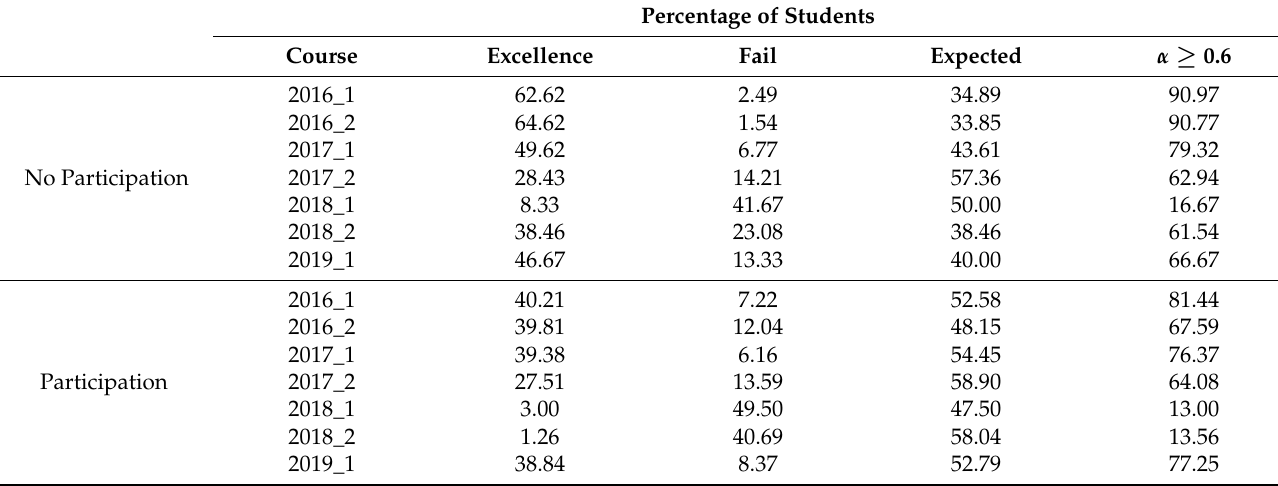
Table 9. Percentage of students according to whether or not they have participated in the support program.